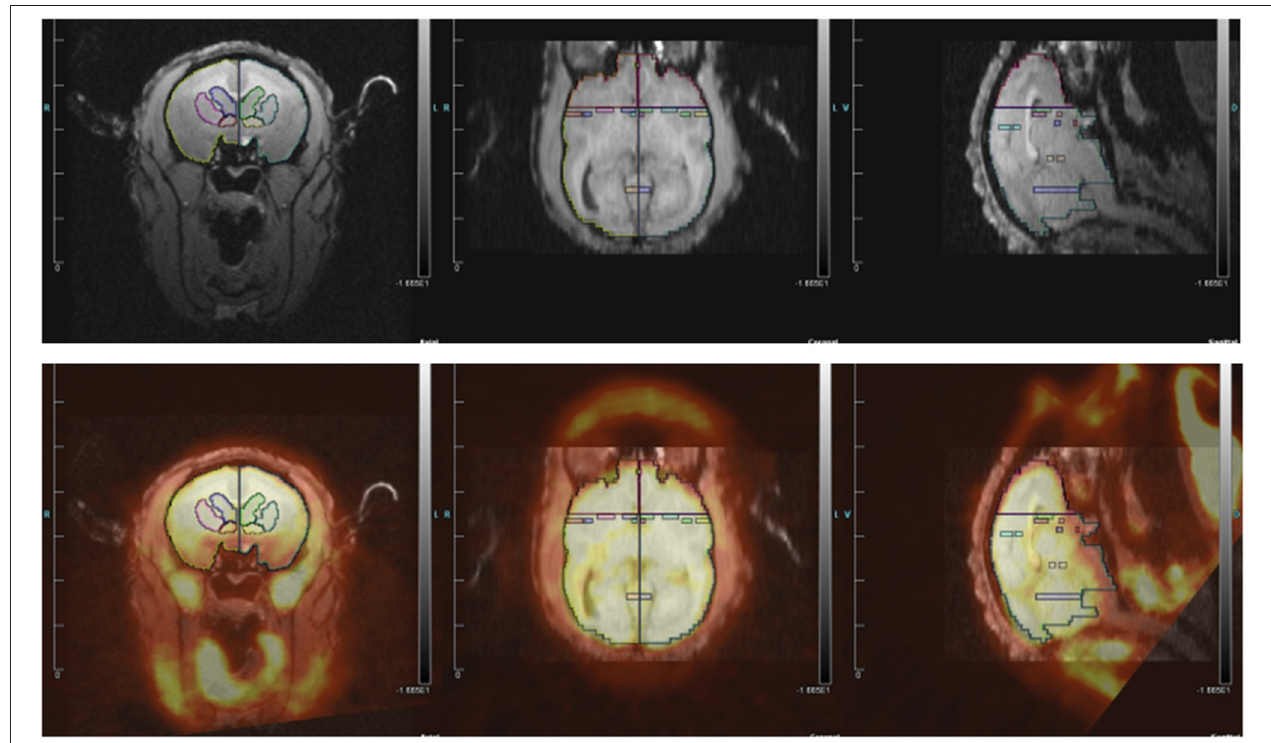
FIGURE 2 | (Top) MRI image with regions of interest. (Bottom) MRI image co-registered with PET for titi monkey in jealousy condition.